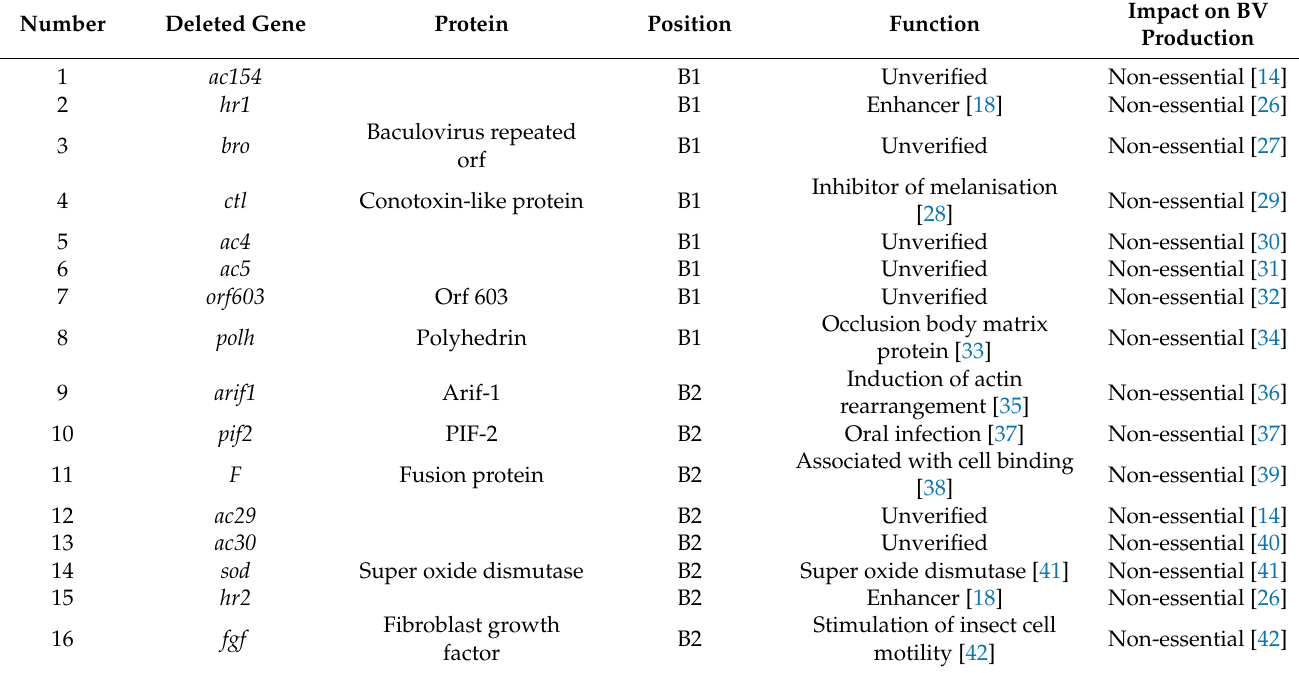
Table 3. Gene deletion in